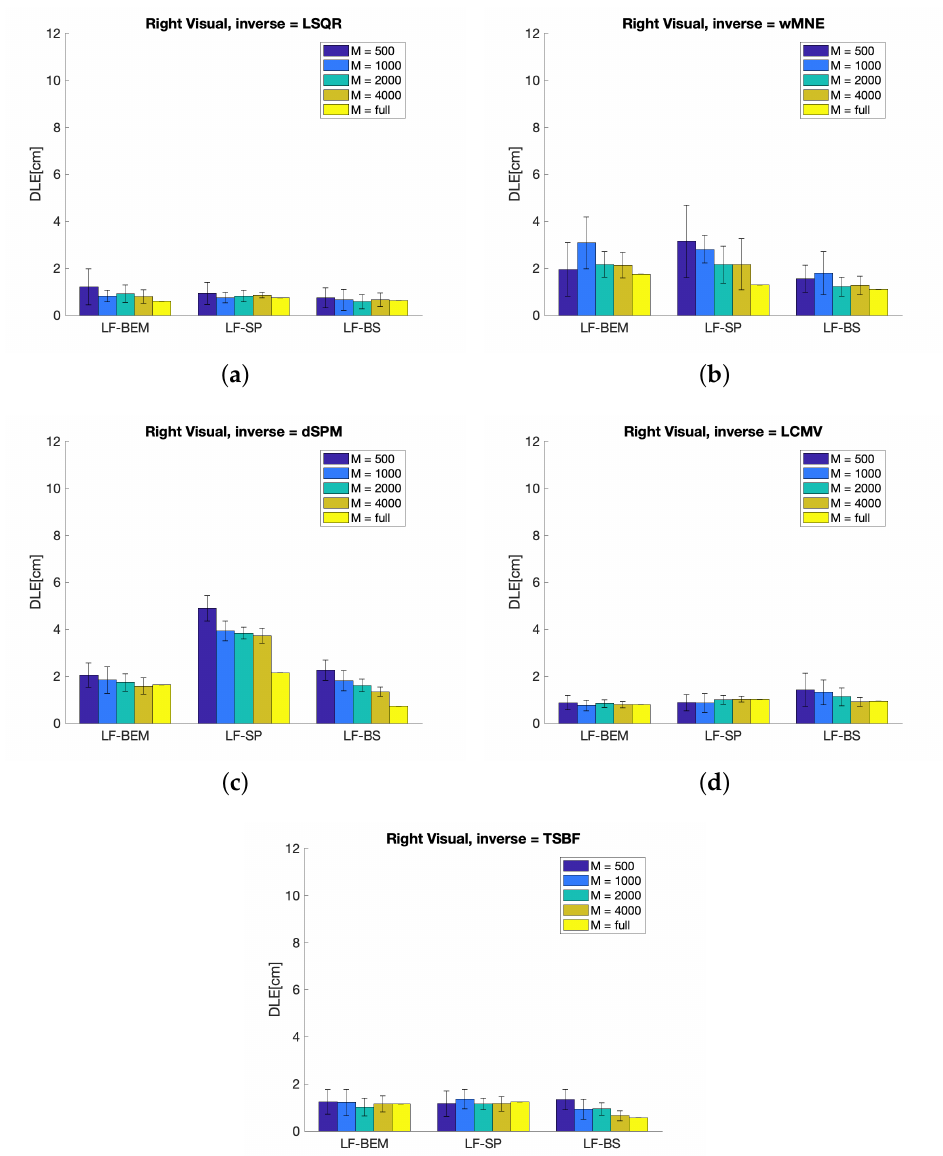
Figure 5. Right Visual evoked field: Mean DLE [cm] and standard deviation obtained averaging over N = 10 runs using LSQR ( a ), wMNE ( b ), dSPM ( c ), LCMV ( d ), and TSBF ( e ) at 90 ms for LF-BEM, LF-SP, and